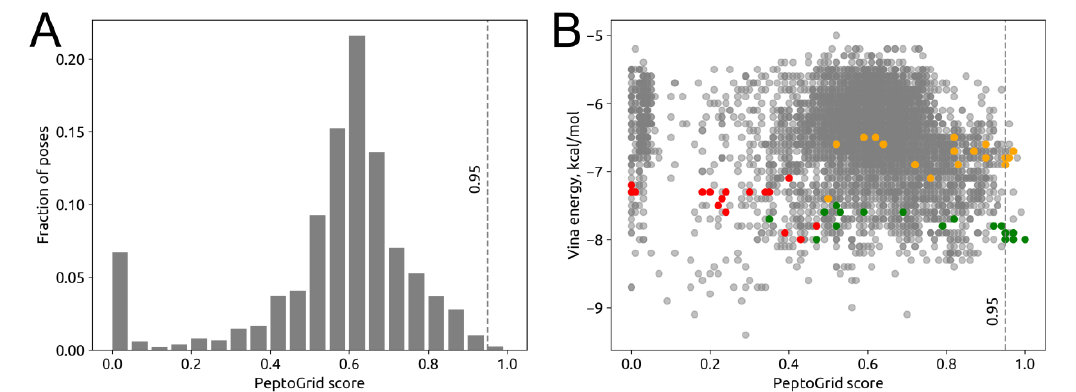
Figure 3. Distribution of PeptoGrid scoring values for GABAB receptor. ( A ) Histogram of PeptoGrid scores. ( B ) Comparison of PeptoGrid score with AutoDock Vina energies. Colors denotes peptides: green is for PYYA, yellow for PSYG and red is for